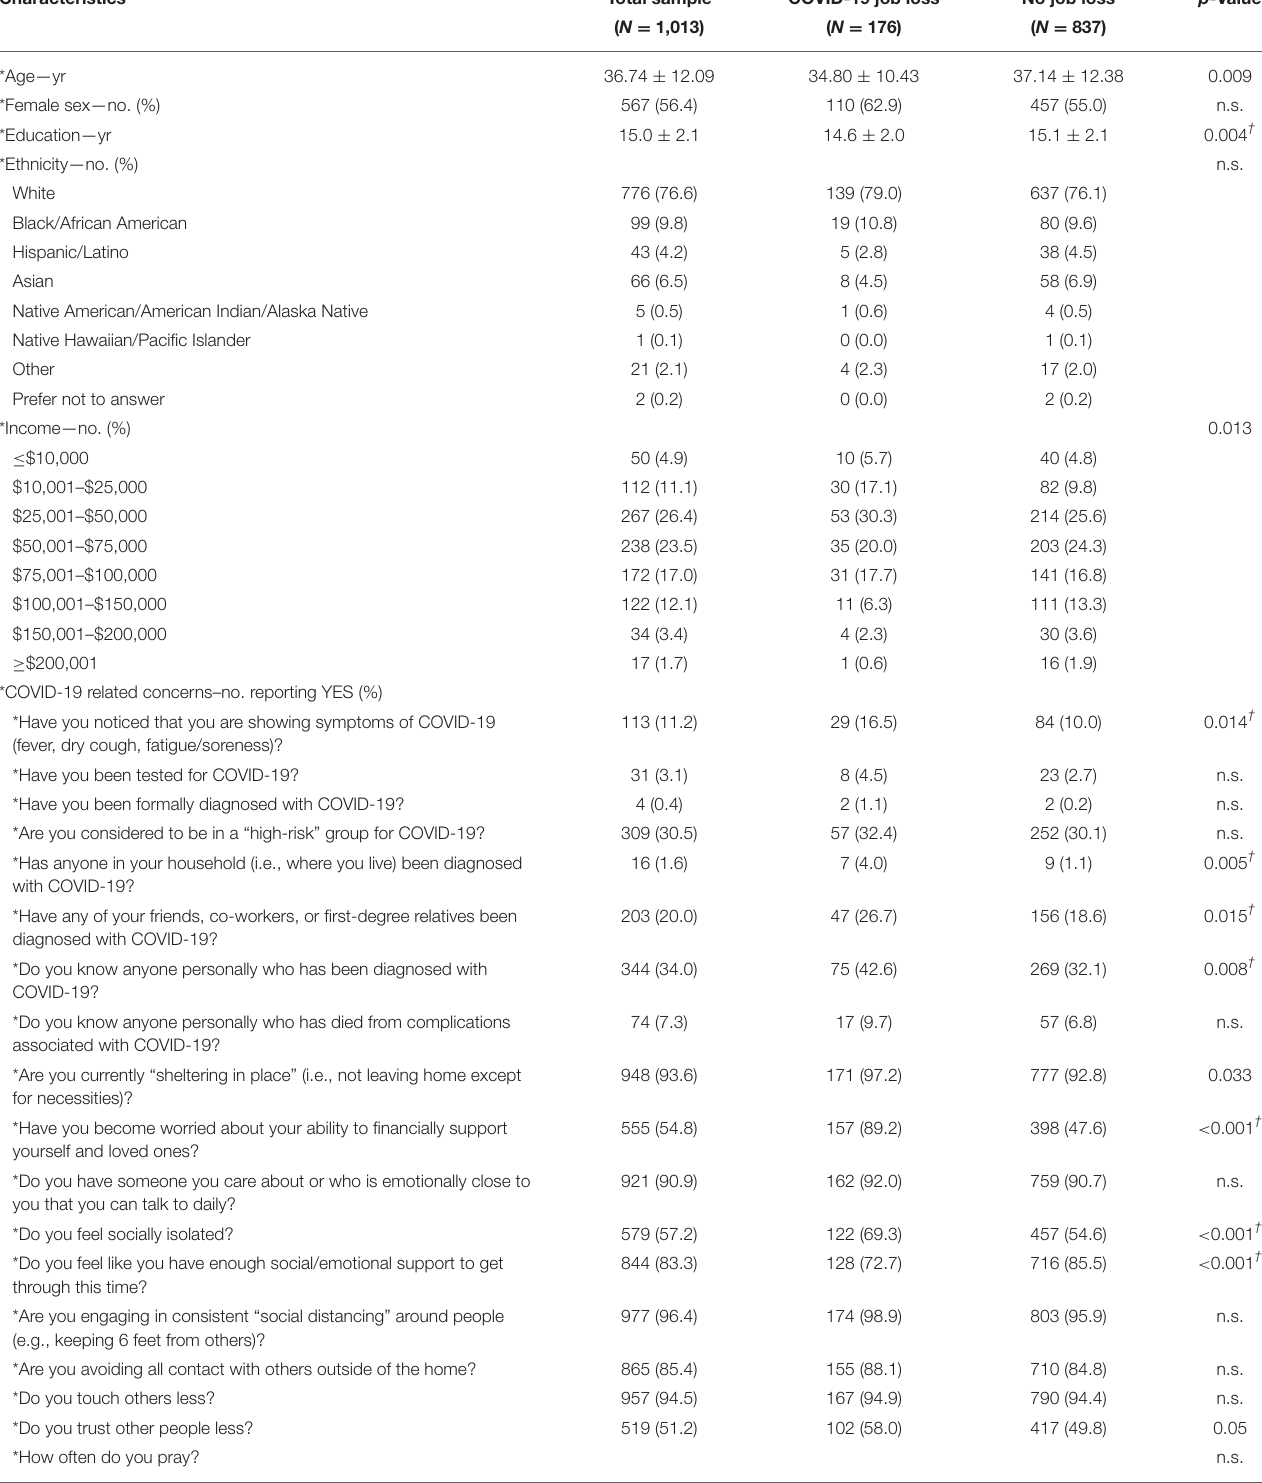
TABLE 1 | Demographic characteristics and COVID-19 concerns of groups of individuals who lost or did not lose their primary employment due to the pandemic.